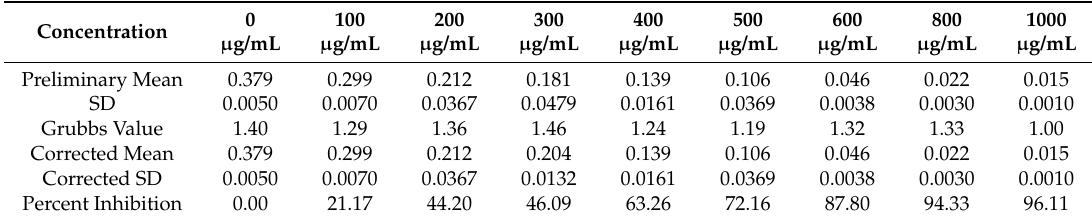
Table 1. DPPH assay raw absorbance data and calculated values for C. sinensis .